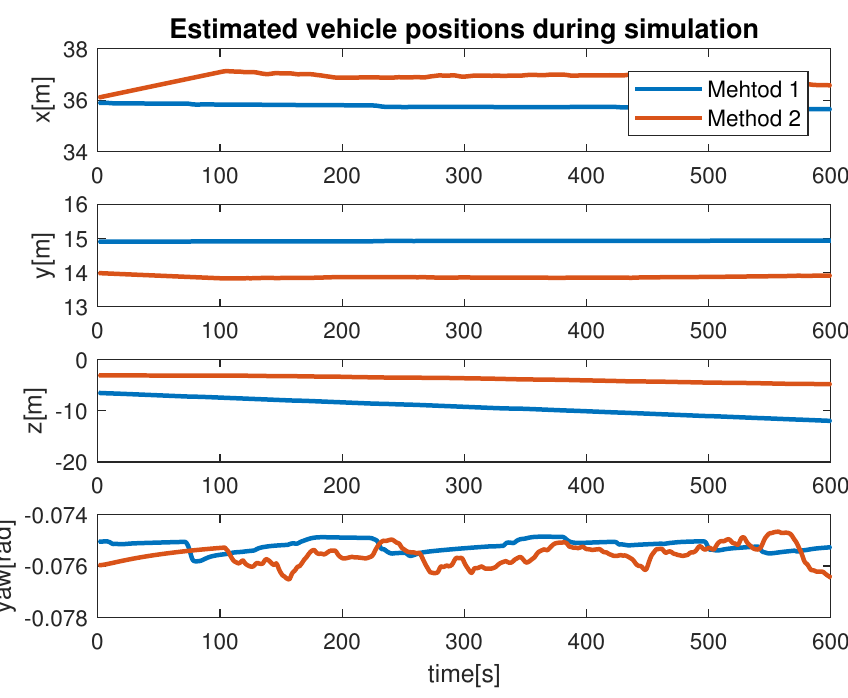
Figure 13. Vehicle positions during